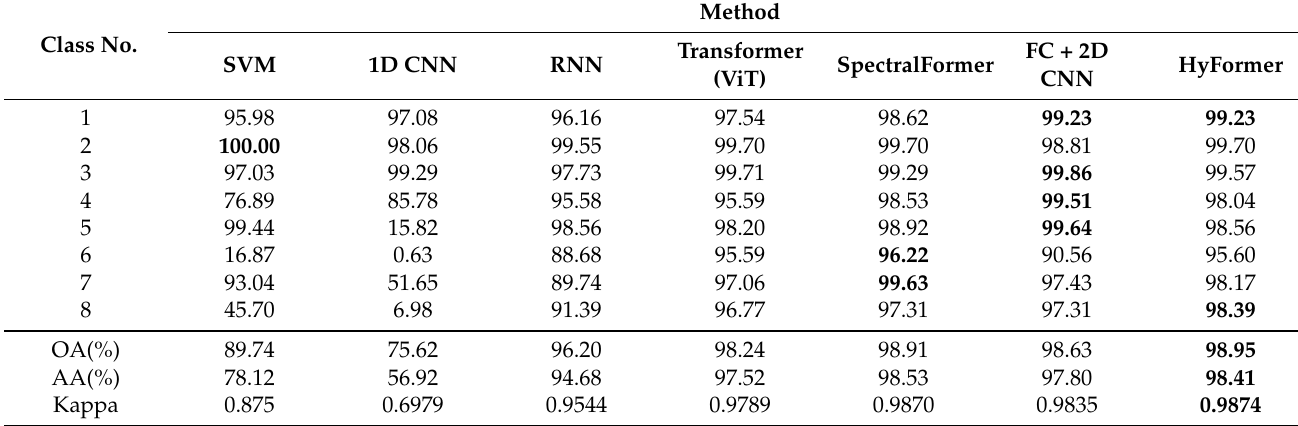
Table 9. Comparison of the classification results of different classification methods on the dataset after adding SWIR